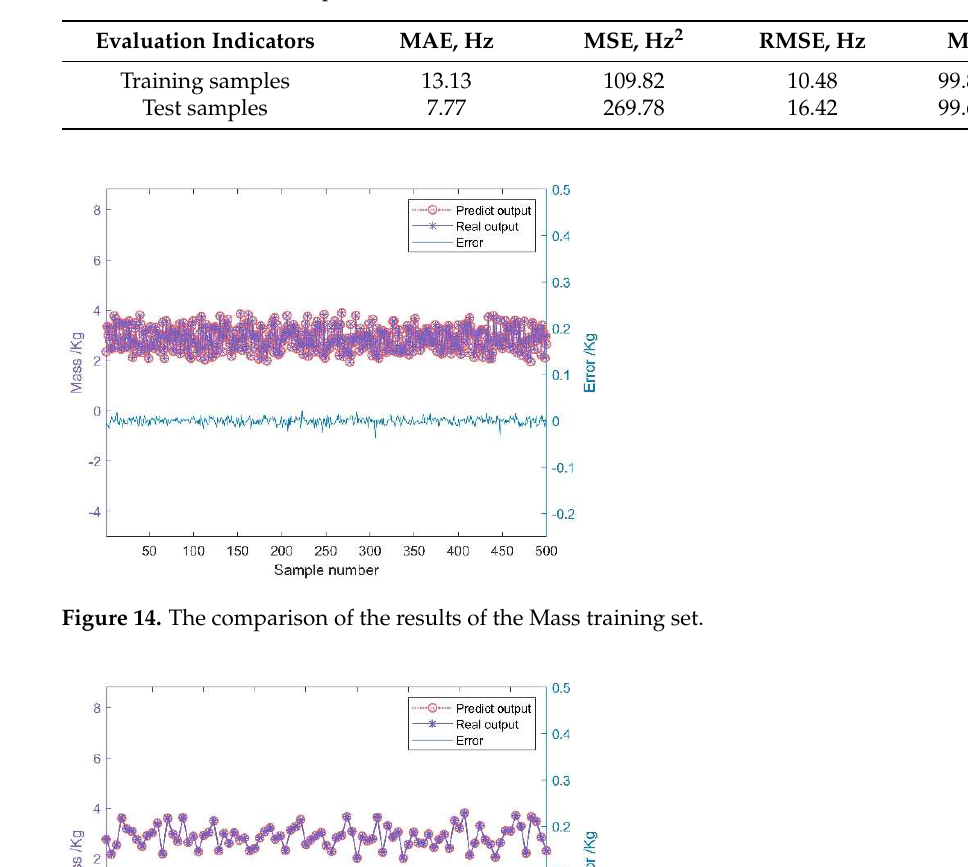
Figure 13. The comparison of the results of the FMF test set. Table 3. Evaluation of the predictive effect of FMF.